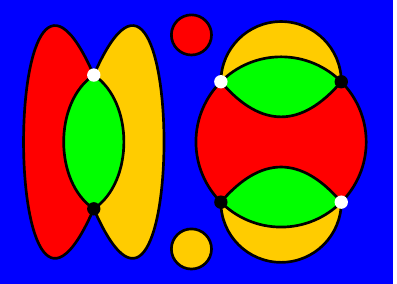
FIG. 4. Illustration of multispinon complexes: a spinon pair (left) with the spinon and antispinon marked as black and white circles, respectively, and a quadruplet (right) consisting of two spinons and two antispinons. Two trivial domains, the yellow and red circles, are also shown. The color coding of the VBS domains is as in Fig. 3 and all domain walls are of the elementary type where the VBS angle twists by Δ ϕ ¼ π = 2